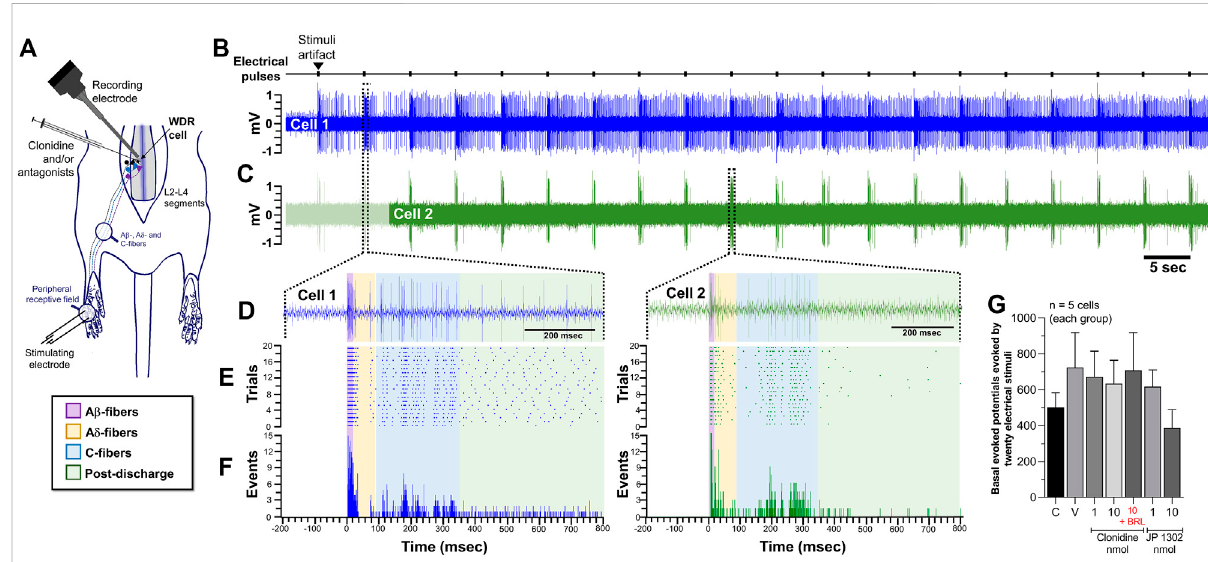
FIGURE 4 Effect of peripheral electrical stimulation on the WDR cell response. (A) Experimental set-up design illustrating the site of electrophysiological recordingofWDRcellsatspinalL2-L4segments,andthelocation,intheipsilateralpawoftheelectricalstimulationappliedtothereceptive fi eld(RF). (B) Rawdataoftwenty stimulusartifactsand (C) rawdataofconsecutiveWDRresponsestoRFstimulationintwodifferentcells(Cell1andCell2). (D) showstherawtracingofasinglesecond-orderWDR neuronclusterresponse induced byoneelectricalstimulus-evokedinCell1(left)orCell2 (right). (E) shows the raster plot and (F) peri-stimulus time histograms (PSTH) constructed from twenty WDR neuronal responses to RF stimulation depicting the different fi ber components (A β -, A δ -, C- fi bers, and post-discharge). Note that, under our experimental condition, no clear wind-up is elicited. (G) shows that the basal response, i.e., the total of action potentials evoked at t = 0 in the different experimental groups, is not statistically different ( χ 2 = 4.535; p =